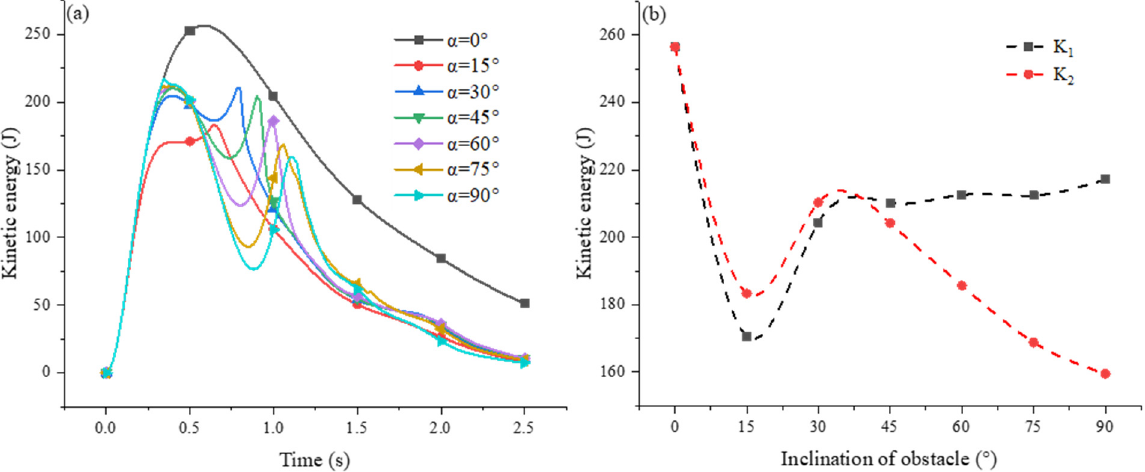
Figure 8. Kinetic energy of tailings flow under different inclinations of obstacle. ( a ) Time-history of kinetic energy; ( b ) first and second peak of kinetic energy.